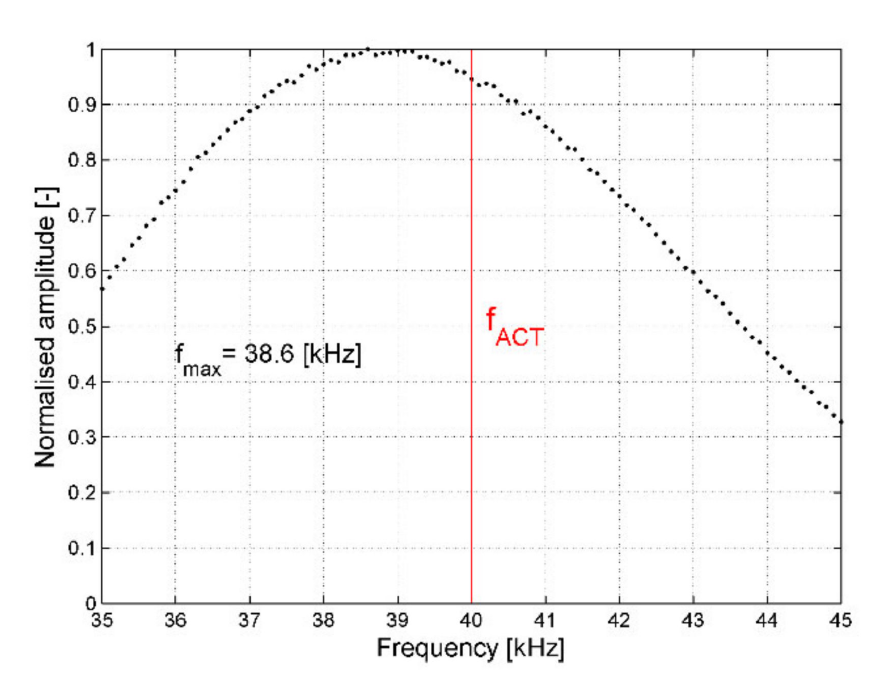
Figure 7. Normalized elastic waves amplitude for various excitation frequency